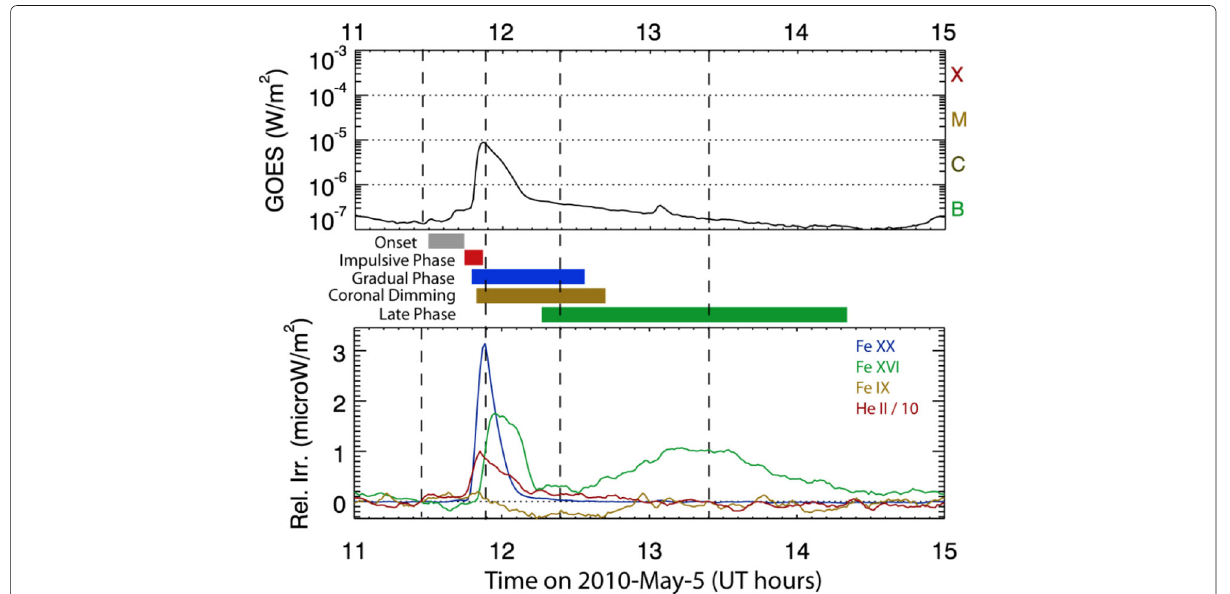
Fig. 8 Example of flare variations. Flare variations for the C8.8 flare on 2010 May 5 as adapted from Woods et al. (2011). The relative irradiance (Rel. Irr.), being the solar irradiance spectrum minus the pre-flare spectrum, represents well the flare variations over its different phases. The transition region He II 30.4 nm emission highlights the impulsive phase. The GOES X-ray (0.1–0.8 nm) defines the gradual phase, and the hot corona Fe XX / Fe XXIII 13.3 nm emission behaves almost identically as the X-ray. The cool corona Fe IX 17.1 nm emission is the EUV emission with the largest amount of coronal dimming that often follows after the impulsive phase. The warm corona Fe XVI 33.5 nm emission has its first peak a few minutes after the X-ray gradual phase peak and then has a second peak many minutes later. The change in slope of the GOES X-ray during the gradual phase is indicative of the late phase contribution (second Fe XVI peak). The four vertical dashed lines, left to right, are for spectra in Figure 9 of the